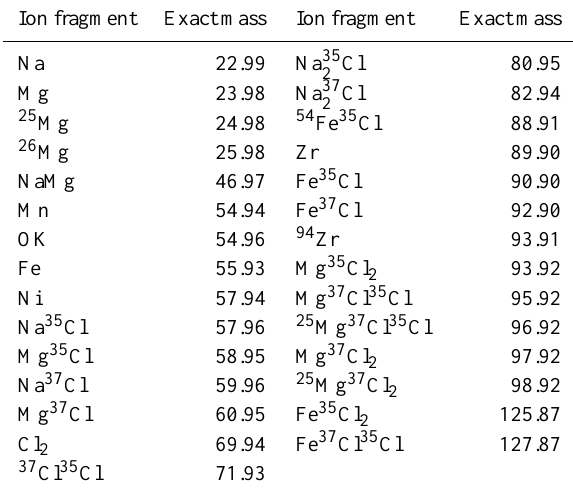
Table 2. Ion fragments considered within the sea salt